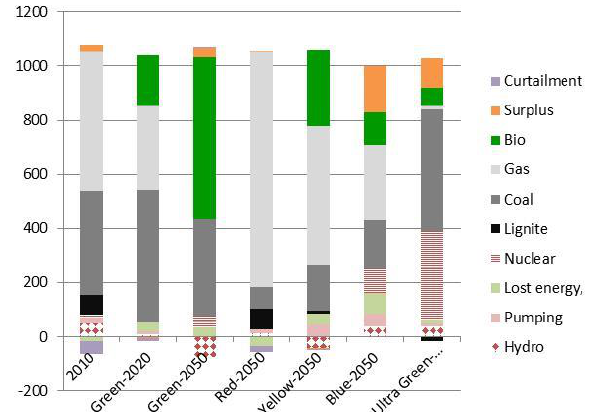
Fig. 9. Development of marginal production portfolio. Fig. 10. Production portfolios for two sensitivity analyses of Green 2050 ("main" scenario to the left, alt i in the middle and alt ii to the